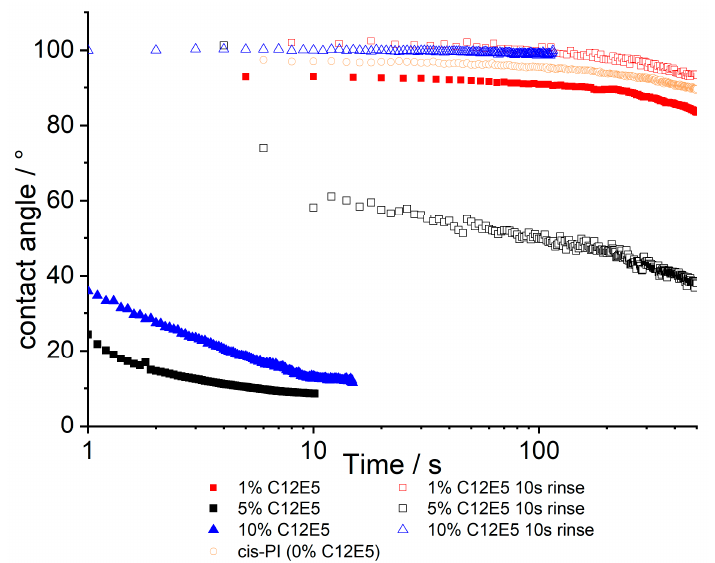
Figure 3. Contact angles for cis -PI films containing between 1 and 10% C 12 E 5 both before and after a 10 s rinse with deionised water. The data are a function of time where 0 is the time that the probe droplet (water) is placed on to the surface. A cis -PI sample has also been shown in orange, showing 0% surfactant loading.